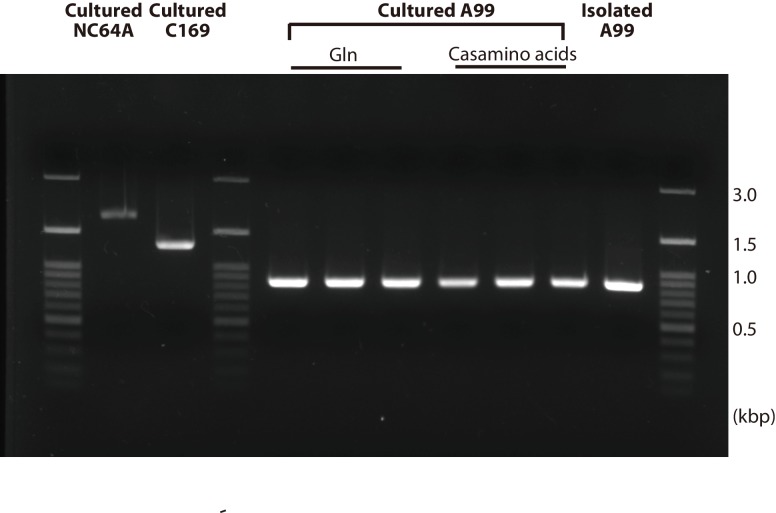
PCR of 18S rRNA genes in cultured algae.PCR amplification of genomic DNA of the 18S rRNA gene was performed in Chlorella A99 shortly after isolation from H. viridissima A99 (Isolated A99), cultured in medium containing glutamine (Glu) and in medium with casamino acids for 12 days, with cultured NC64A and C169 added for comparison.